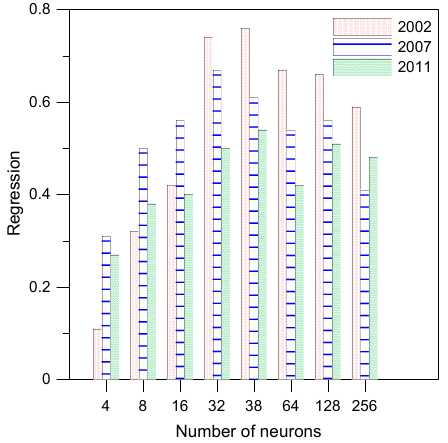
Figure 4. The results of the regression for different number of the neurons.